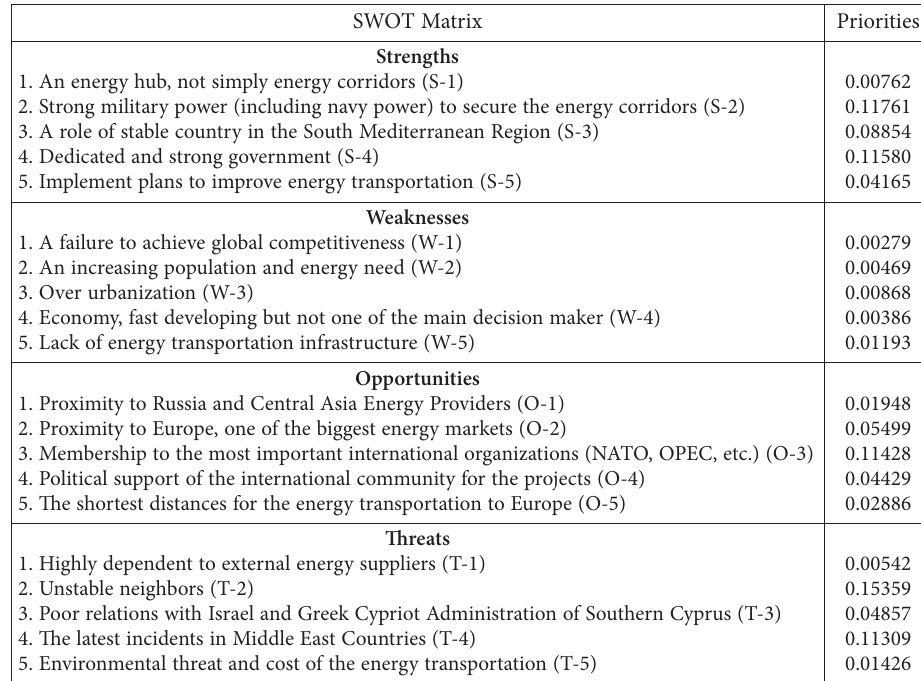
Table 8. The criteria priorities obtained by ANP